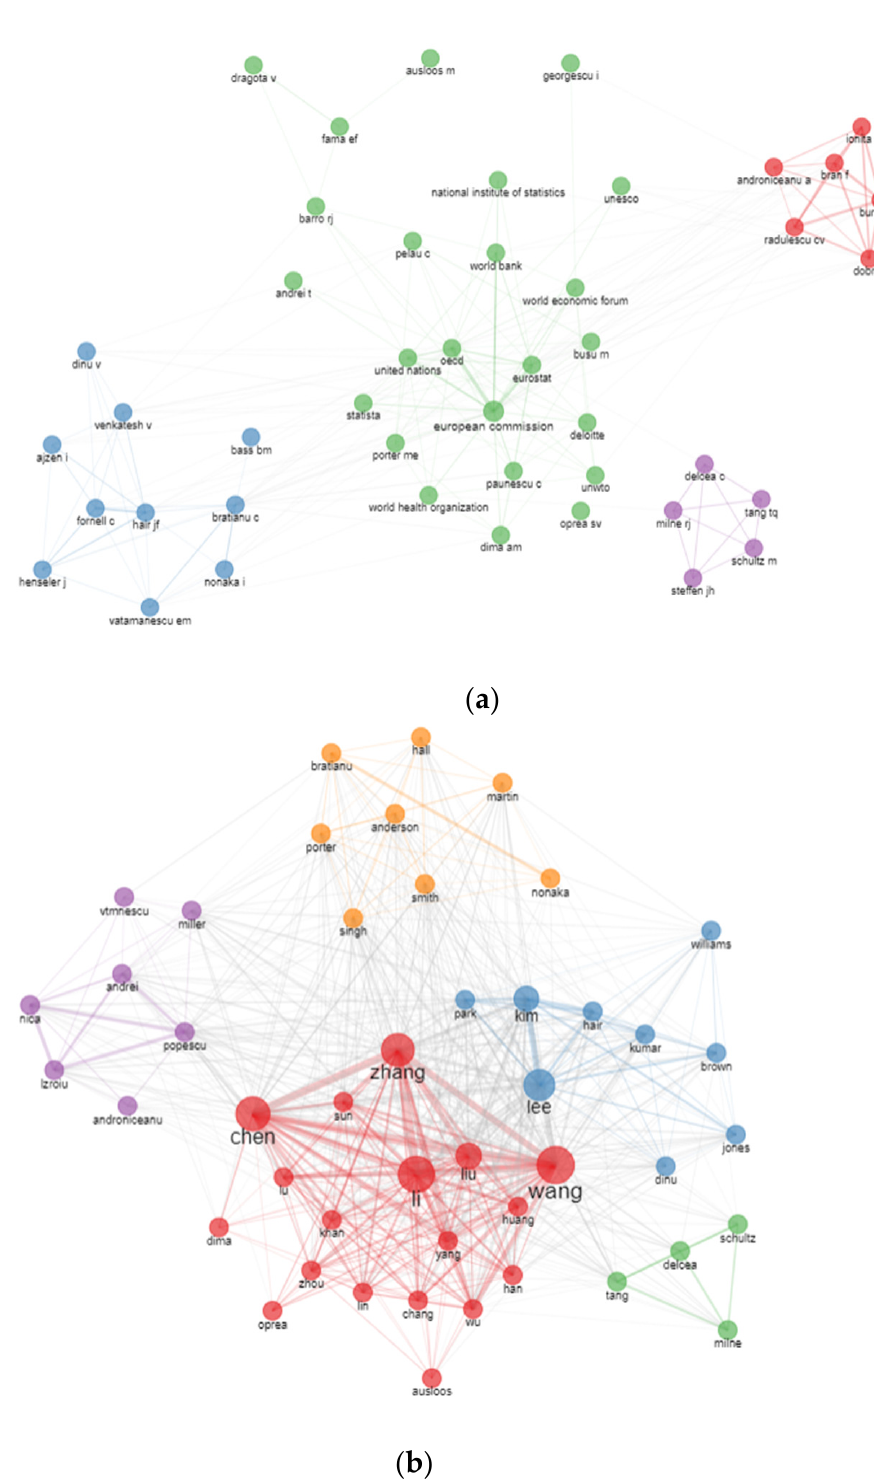
Figure 13. Co-citation network analysis on authors. ( a ) WoS. ( b ) Scopus.